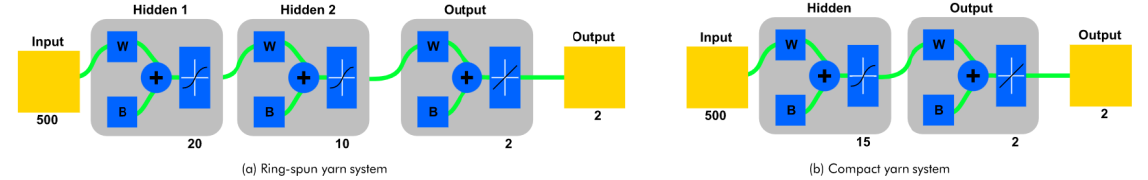
Figure 9. The tenacity and % elongation architectures of the neural network: ( a ) Ring yarn system (left), ( b ) compact yarn system (right) (Adapted from [12]).